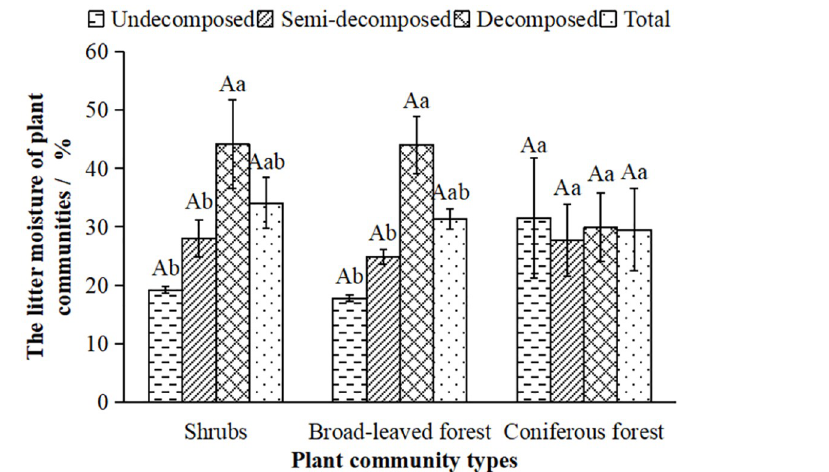
) of litter in the typical plant wmax